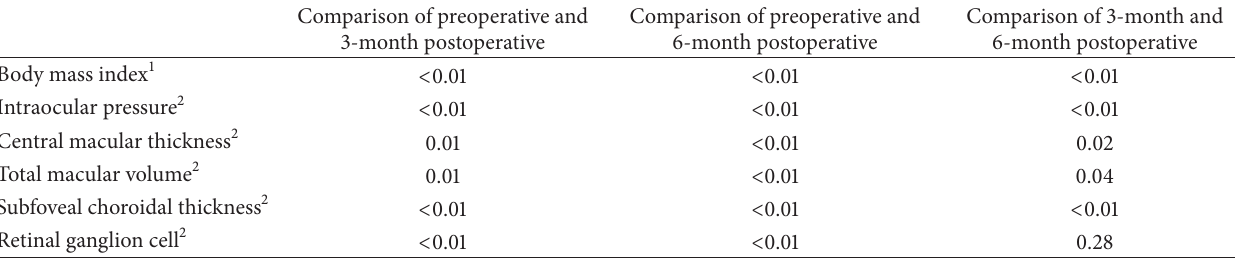
Table 2: Binary comparison of preoperative and postoperative 3-month and 6-month values.